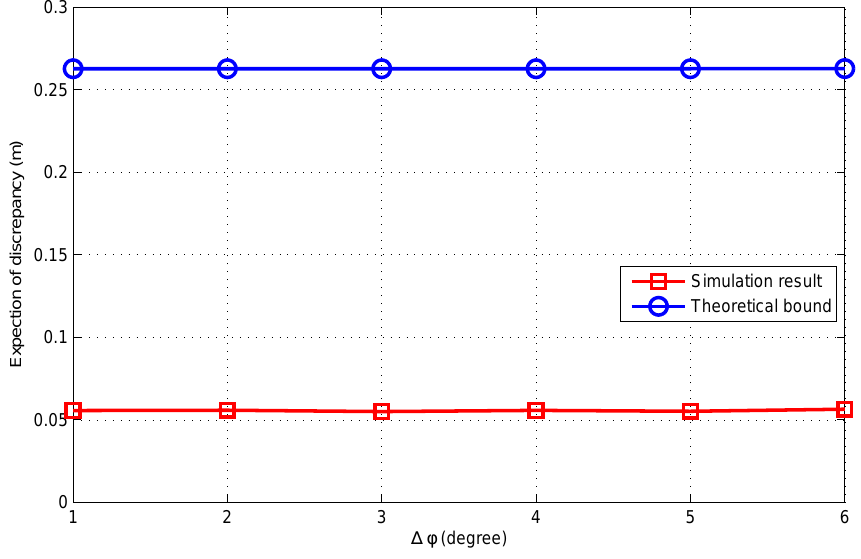
Figure 5. Performance analysis versus different orientation angle deviations.